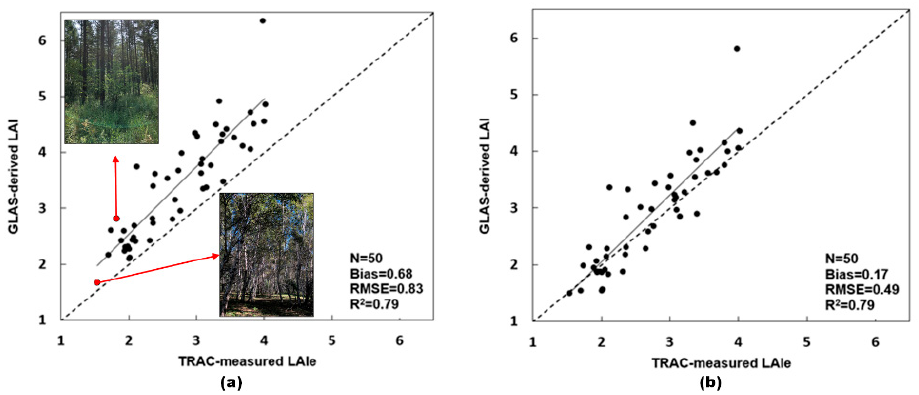
Figure 6. ( a ) Scatter plot of the GLAS LAI and tracing radiation and architecture of canopies (TRAC)-measured effective LAI. The red circles are different typical examples that were used to compare and describe the difference in affecting the inconsistency between satellite retrievals and ground observations, most likely caused by the understory. The photos pointed by the arrows show the situation of vegetation within the GLAS footprints. ( b ) Scatter plot of the recalculated GLAS LAI (i.e., an integration of leaf area density (LAD) from the canopy top to the layer 1 m above the ground) and TRAC-measured effective LAI.